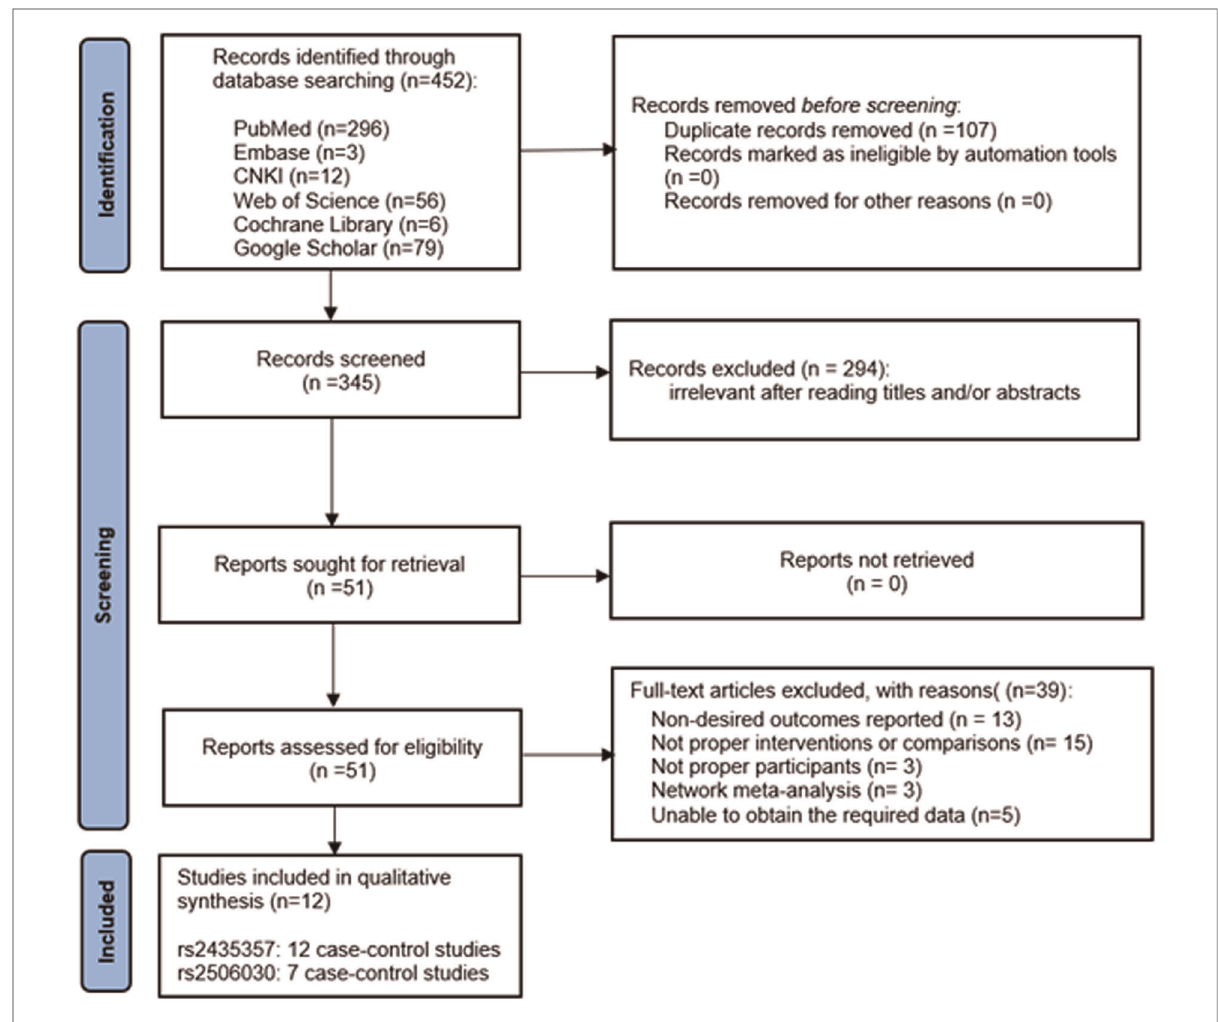
FIGURE 1 PRISMA fl ow diagram for literature research and data